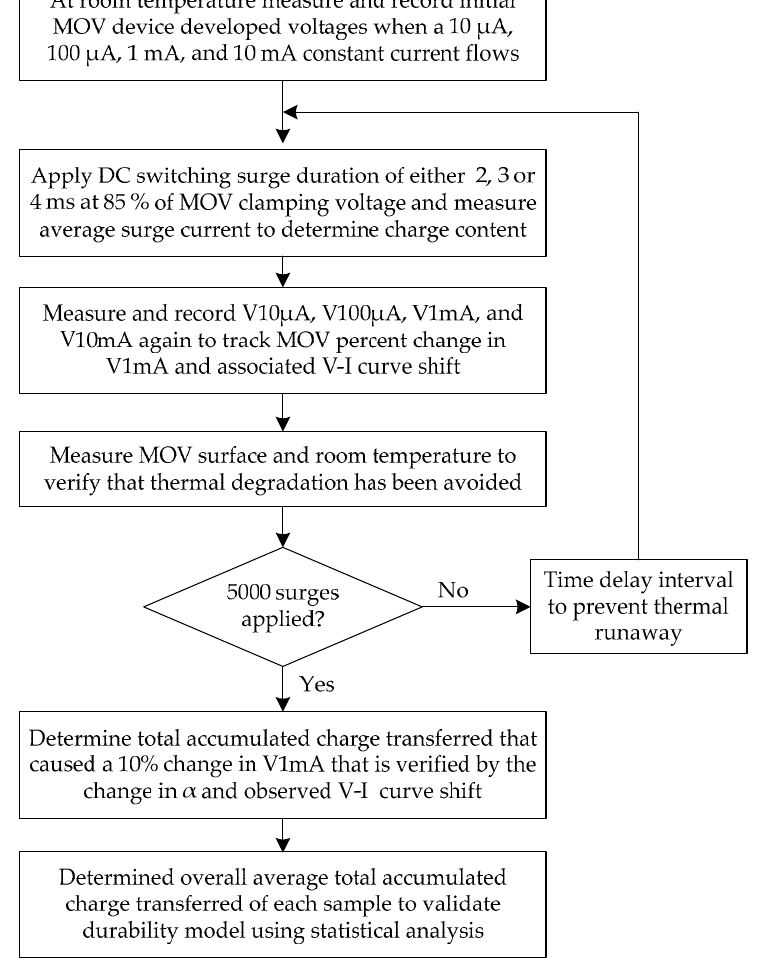
Figure 1. Research method flowchart used to validate proposed durability model.